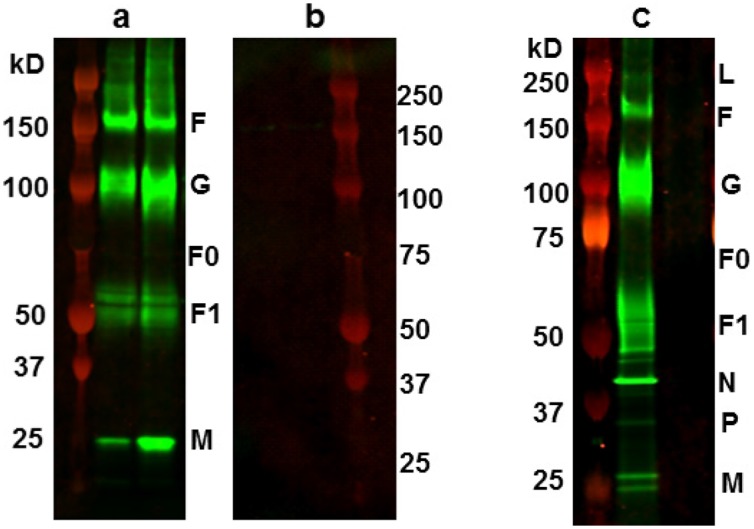
VLP-incorporated RSV proteins.The VLPs were harvested and purified as described and then processed and analyzed by SDS-PAGE. Panel A: The VLP-incorporated RSV proteins shown in two different representative preparations of purified VLPs were consistent in size to RSV M, F1 and G proteins. The precursor F0 protein and the F2 fragment were difficult to discern. An additional F protein band, a trimer, was visible in the VLPs and the virus in Panel C. The specificity of the RSV proteins in the VLPs was confirmed by the presence of equivalent sized proteins (kD) in RSV A2 virus (Panel C) and by their absence in the similarly processed “mock” particles (Panel B).